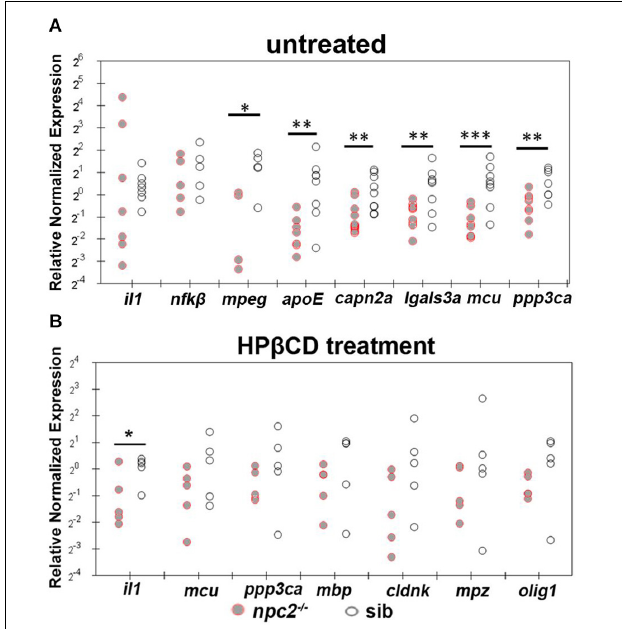
FIGURE 10 | Treatment with 2-hydroxypropyl- β -cyclodextrin increased the expression of genes that are related to inflammation and Ca 2 + homeostasis in 5 dpf npc2 − / − larvae to wildtype levels. Scatterplots show the normalized expression of selected genes in untreated larvae (A) and larvae that were treated with 2 mM 2HP β CD (B) at 5 dpf. Each circle corresponds to one zebrafish. The 18 S ribosomal gene was used as a reference. The experiments were performed in triplicate. *** p < 0 . 001, ** p < 0.01, * p <